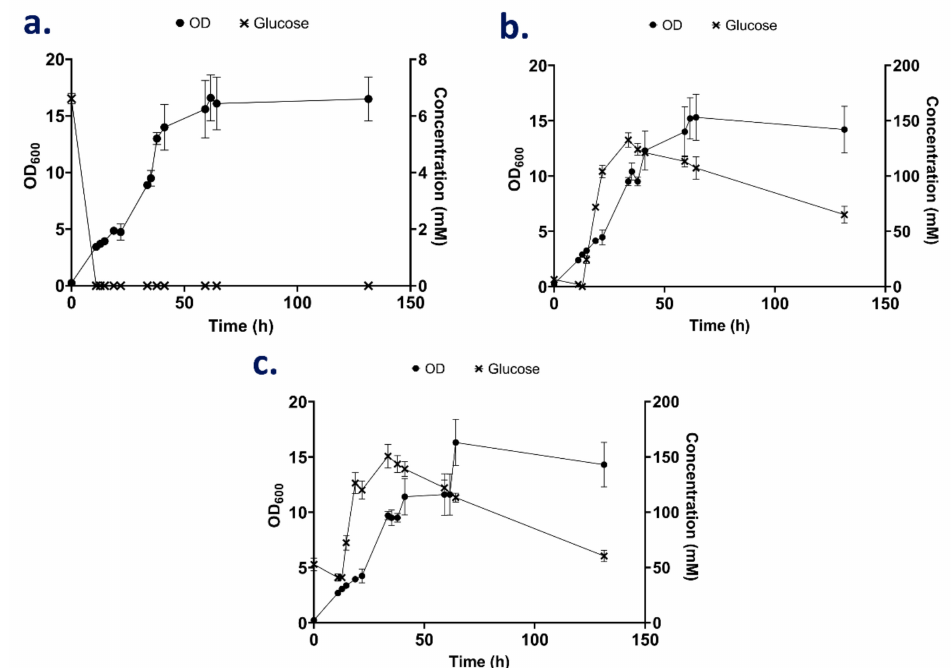
Figure 4. Fed-batch cultivation of SOS3 in semi defined media. ( a ) MMS + MMS. ( b ) MM + G-MMS. ( c ) G-MMS + G-MMS. Data correspond to the average of two